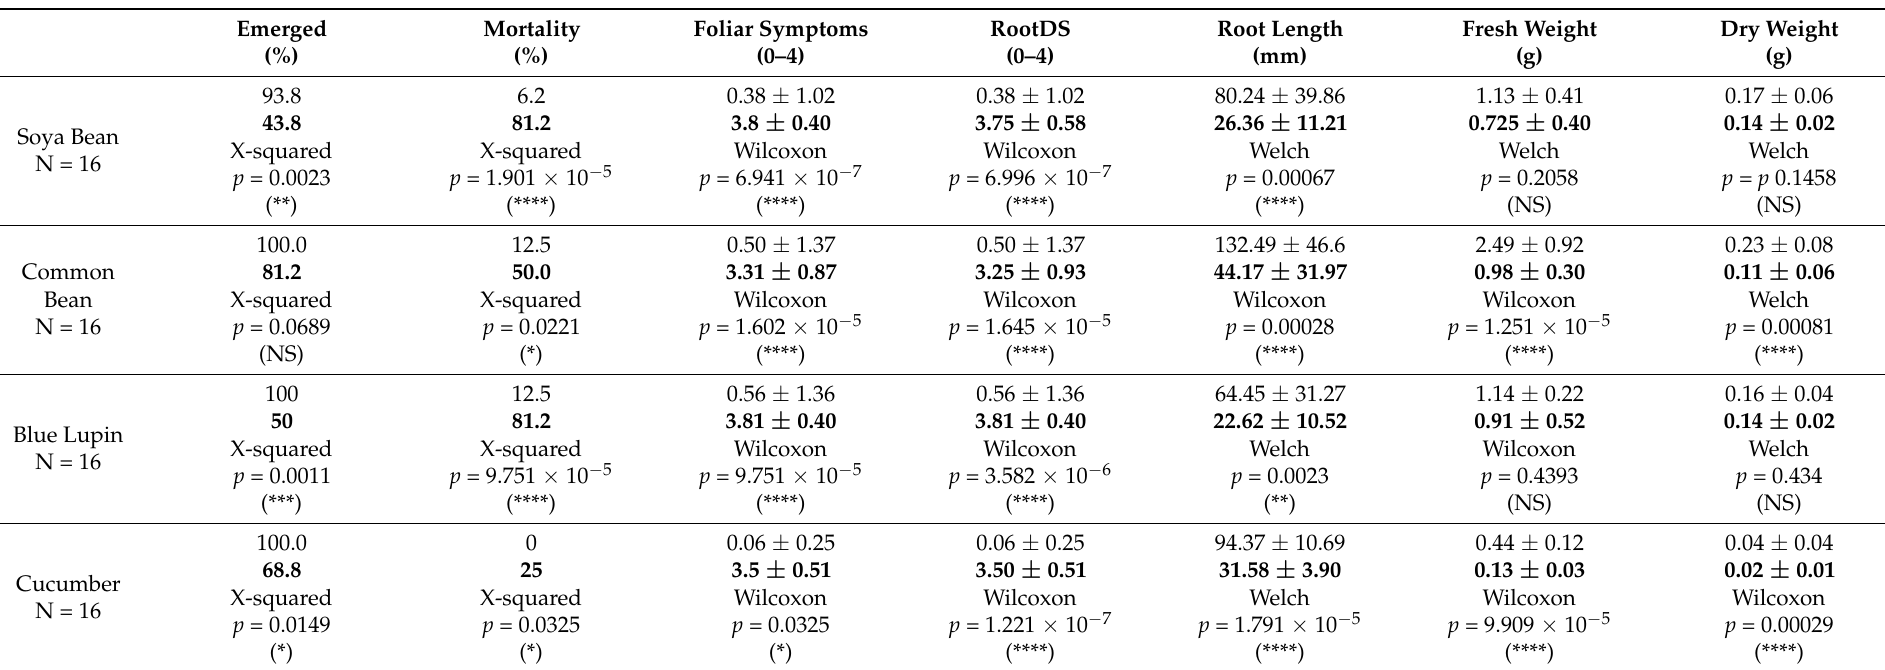
Table 2. In vivo tests comparing seedling emergence, pathogenicity, foliar symptoms, root disease severity index, root lengths and fresh and dry weights for soya bean, common bean, blue lupin and cucumber seed inoculated with Py. kashmirense (rows in bold) compared with controls. Data are mean ± SD for each factor and the p -value (for emerged and pathogenicity, sample proportions are shown instead of the mean and SD). NS means p > 0.05, * means p ≤ 0.05, ** means p ≤ 0.01, *** means p ≤ 0.001, **** means p ≤